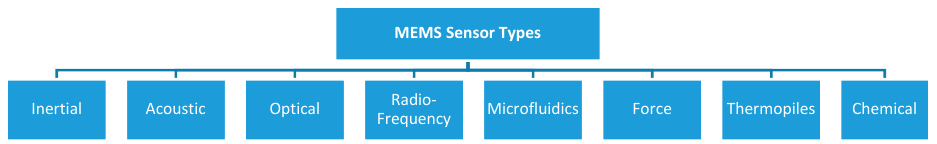
Figure 2. Classification of MEMS sensor types.